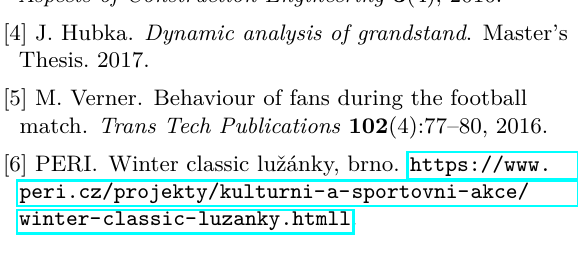
teams in the regular season and in the playoffs.